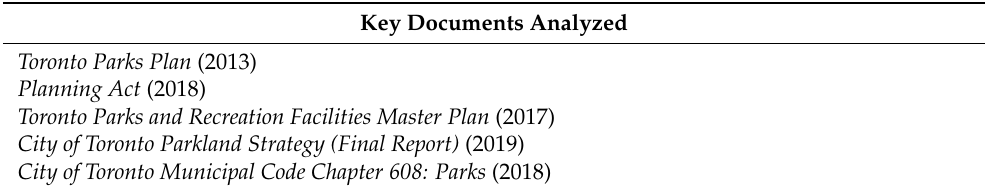
Table 1. Key municipal documents